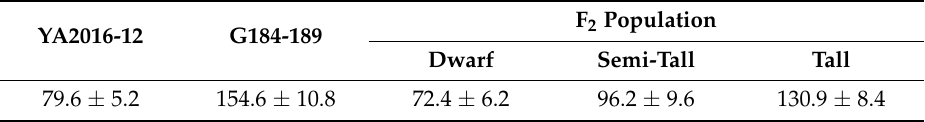
Table 2. Correlation of plant height to first primary branch height, main inflorescence length, and branch segment length based on the F 2 population.